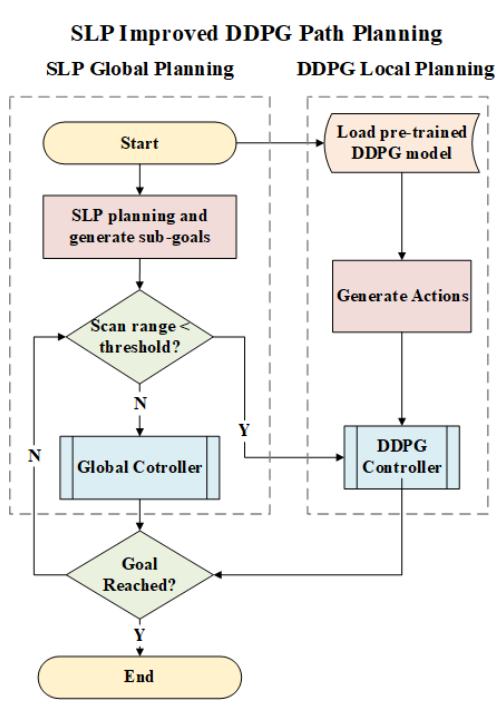
Figure 3. Process